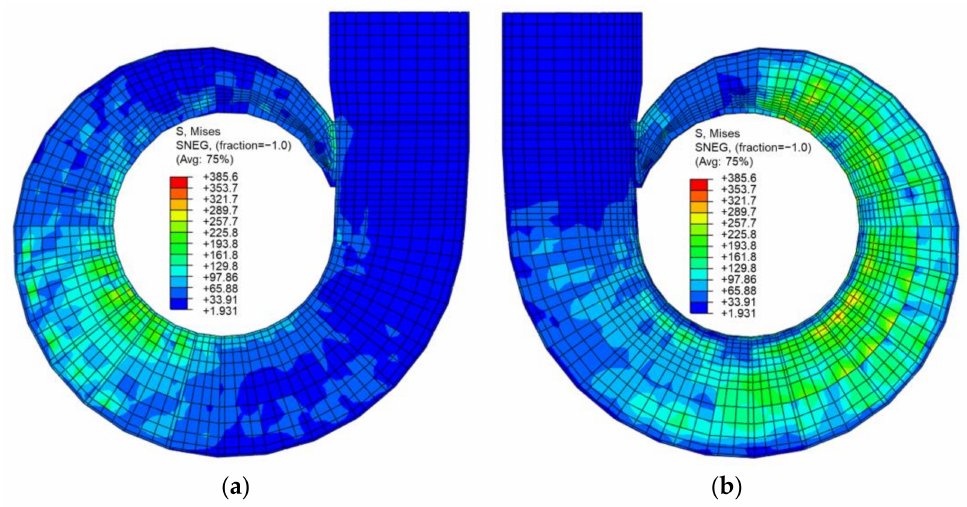
Figure 16. Mises stress of the SSC (unwatered case) (MPa): ( a ) top view; ( b ) bottom